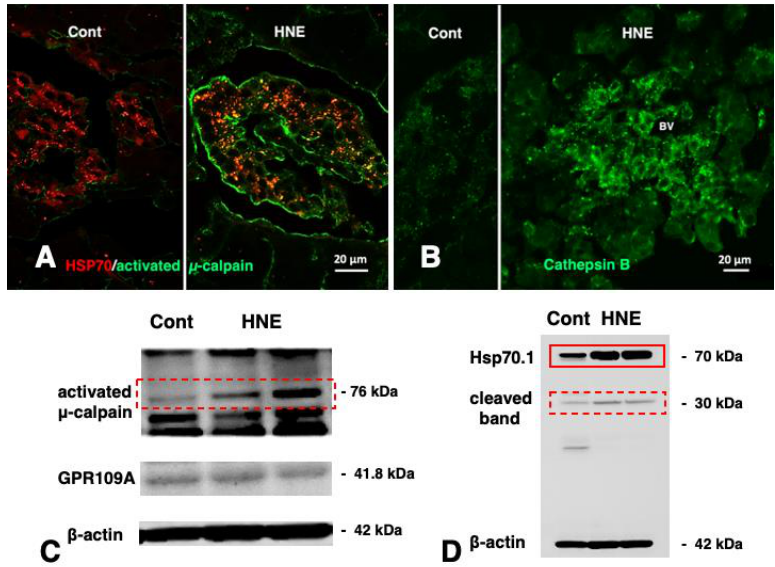
Figure 5. Calpain activation ( A , C ), Hsp70.1 cleavage ( D ), and cathepsin B leakage ( B ) in the Lang- erhans islets of the monkey pancreas after hydroxynonenal (HNE) injections. Activated μ-calpain immunoreactivity (( A ) green) is negligible before hydroxynonenal injections (( A ) Cont), whereas an increment of activated μ-calpain immunoreactivity occurs after hydroxynonenal injections (( A ) HNE). After hydroxynonenal injections, activated μ-calpain immunoreactivity (( A ) green) is colo- calized with Hsp70.1 immunoreactivity (( A ) red), showing a merged color (( A ) HNE, yellow). This indicates interaction of activated μ-calpain with Hsp70.1, because the anti-μ-calpain antibody uti- lized here recognizes only the activated form but does not react with the inactivated form (Yama-